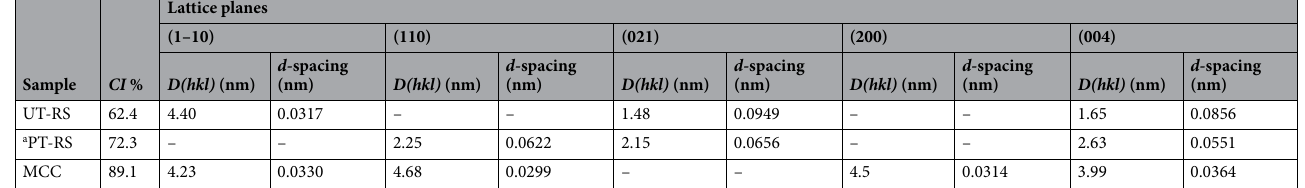
Table 5. Crystallite sizes, inter-planar (d) spacing, crystallinity indices of rice straw cellulose before and after DES pretreatment, with microcrystalline cellulose (MCC) as a reference. UT-RS untreated rice straw,